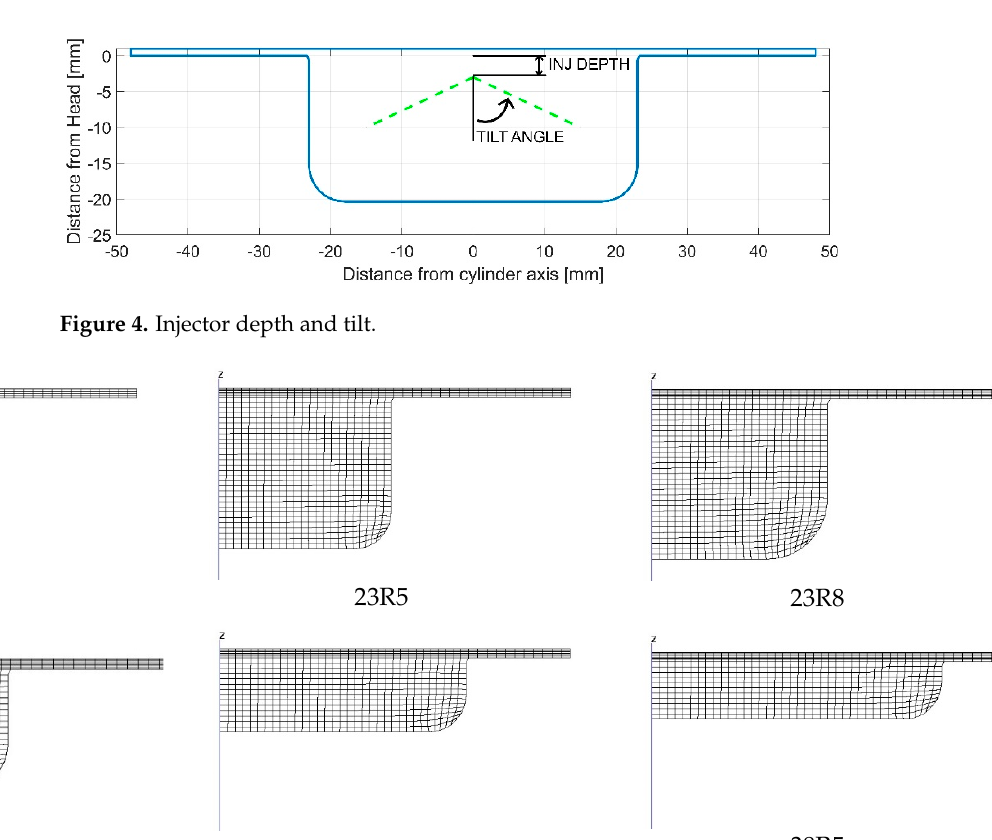
Table 6. Details of the analyzed combustion systems .